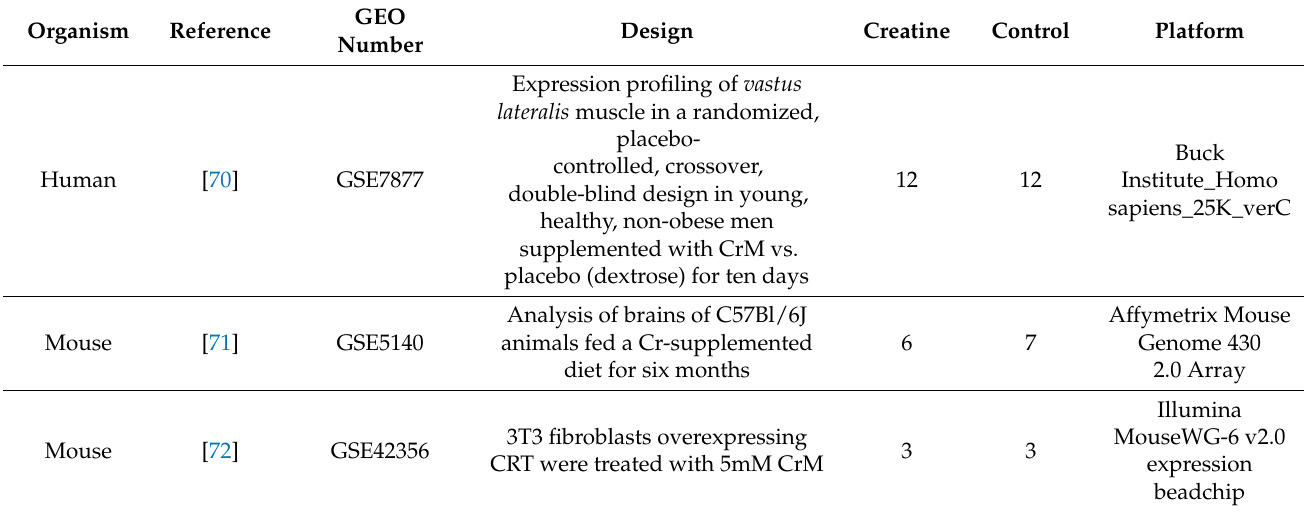
Table 1. Datasets used in the convergent functional genomic analysis.